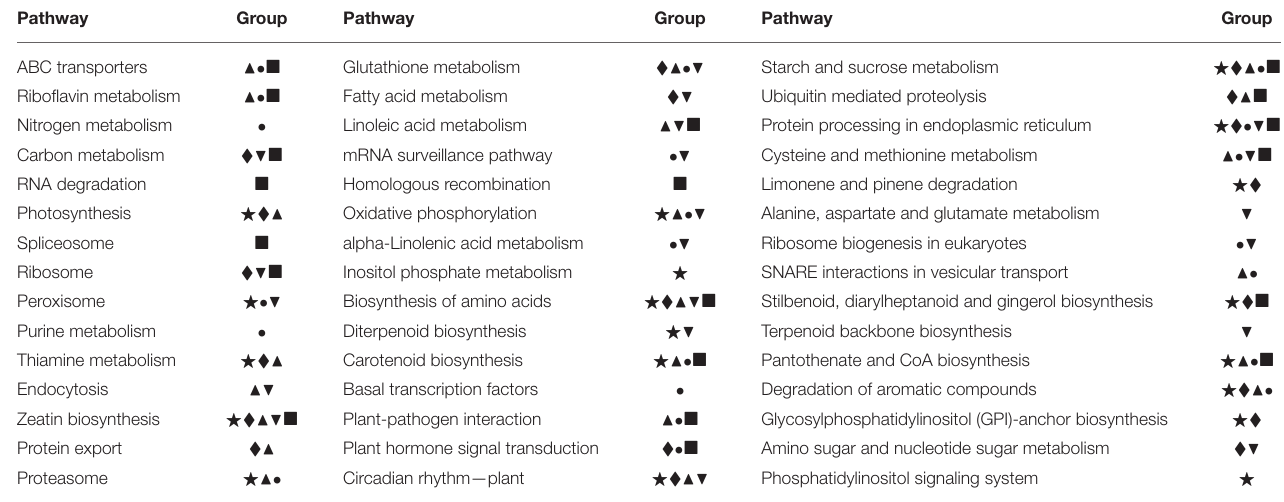
TABLE 2 | The top 20 KEGG pathways enriched by target genes of DE miRNA in 6 groups.